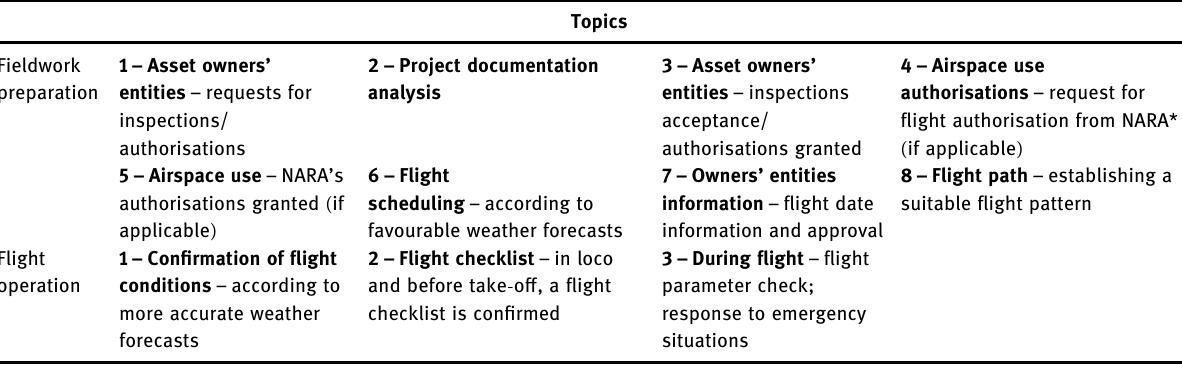
Table 3: Summary of pre fl ight and drone fl ight procedures ( “ Case B ” )